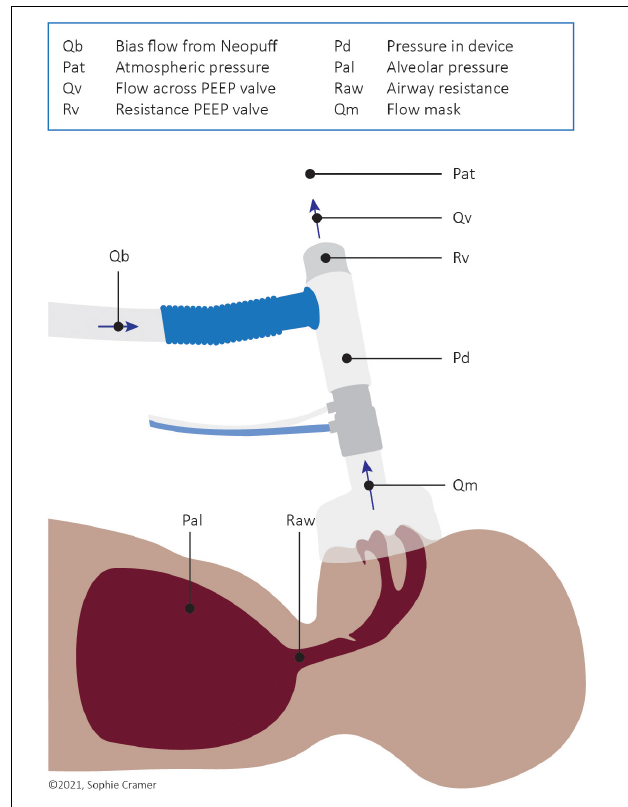
FIGURE 1 | Schematic visualisation of flows, pressures, and resistance during spontaneous